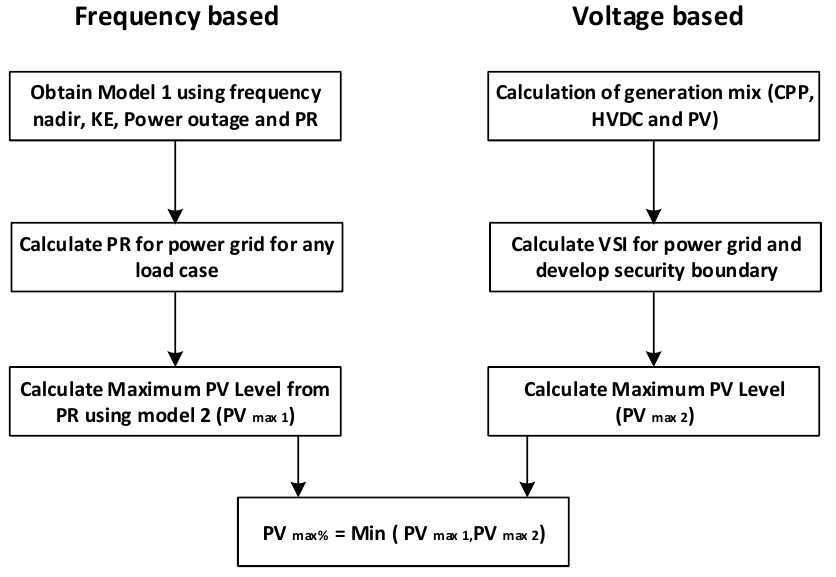
Figure 10. Flowchart for combined PV max% estimation.